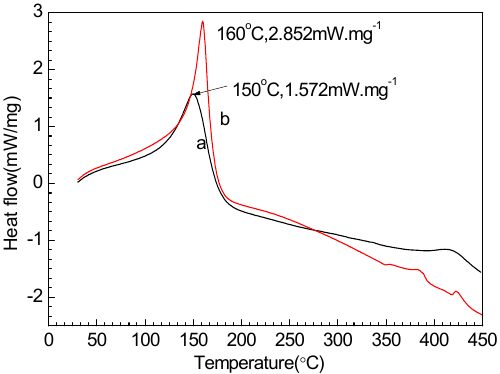
Figure 2. Di ff erential scanning calorimetry (DSC) curves of pure thermopolyurethane (TPU) (a) and Figure 2. Differential scanning calorimetry (DSC) curves of pure thermopolyurethane (TPU) ( a ) and RGO / NCC-TPU composites containing graphene of 1.5 wt% RGO/NCC-TPU composites containing graphene of 1.5 wt% ( b ).